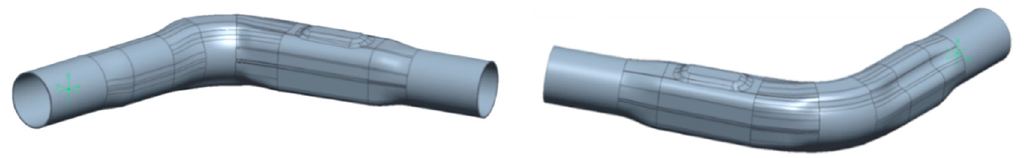
Figure 1. Demonstrator geometry. Table 1. Chemical compound of Docol PHS 1800 by SSAB.